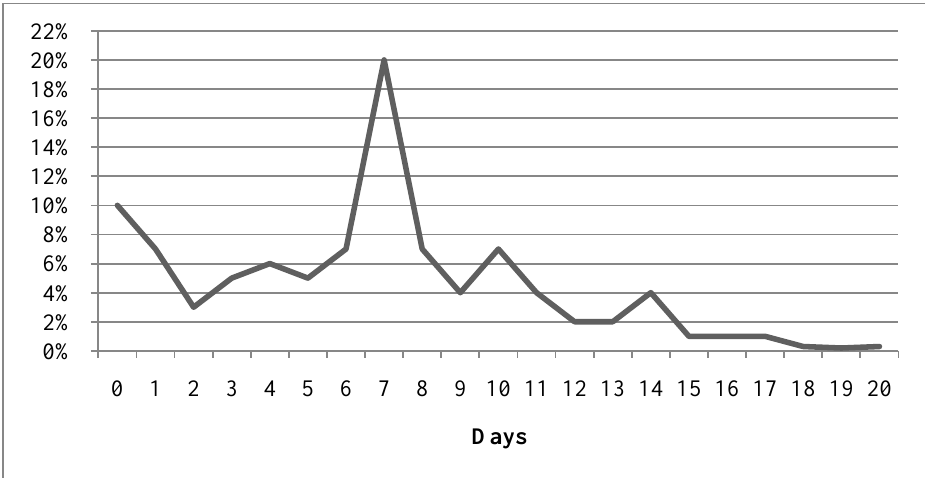
Figure 1. Percentages distribution of days between consecutive charges of electronic